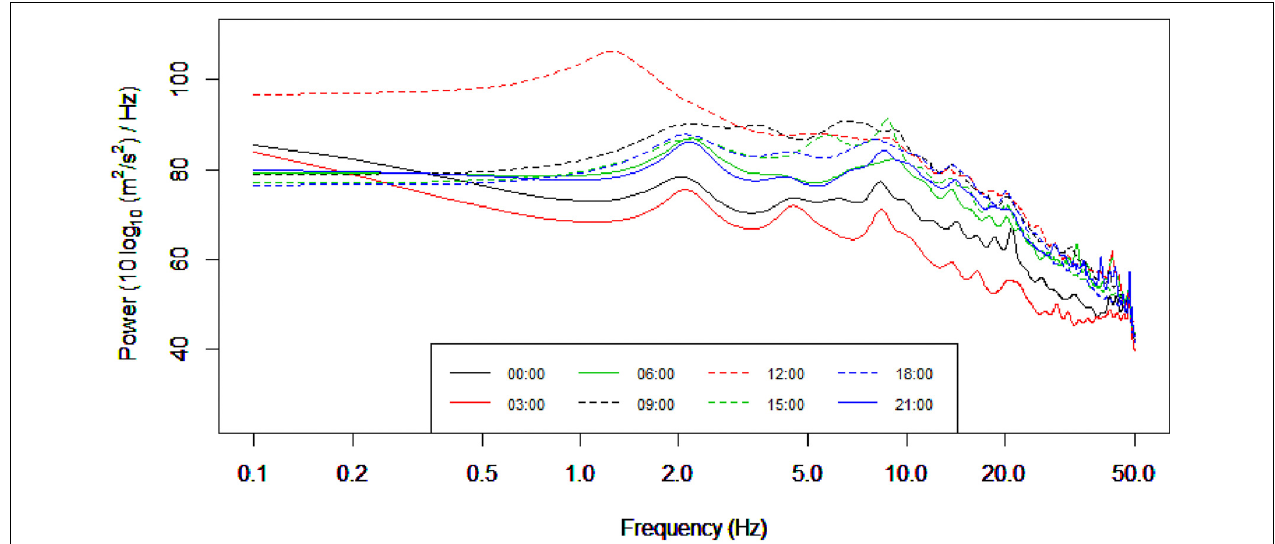
FIGURE 4 | Frequency spectrum for various times in Mataram City at the same location. The solid line represents quiet times and the dashed line represents busy